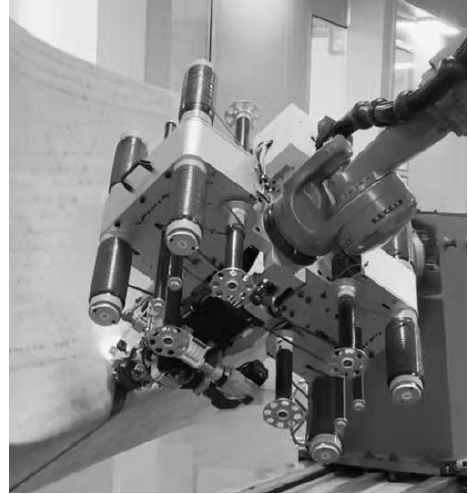
Figure 19. Engineering case: a part with a complex curved surface made by a robotic AFP machine.